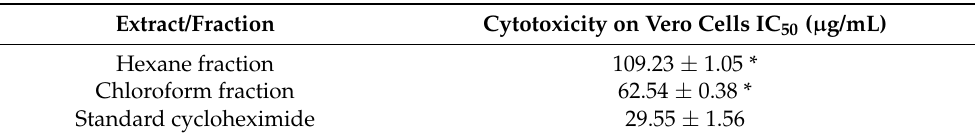
Table 3. Cytotoxic activity (IC 50 ) of Vero cells treated with hexane and chloroform fractions of C. minima , compared to the standard cycloheximide.